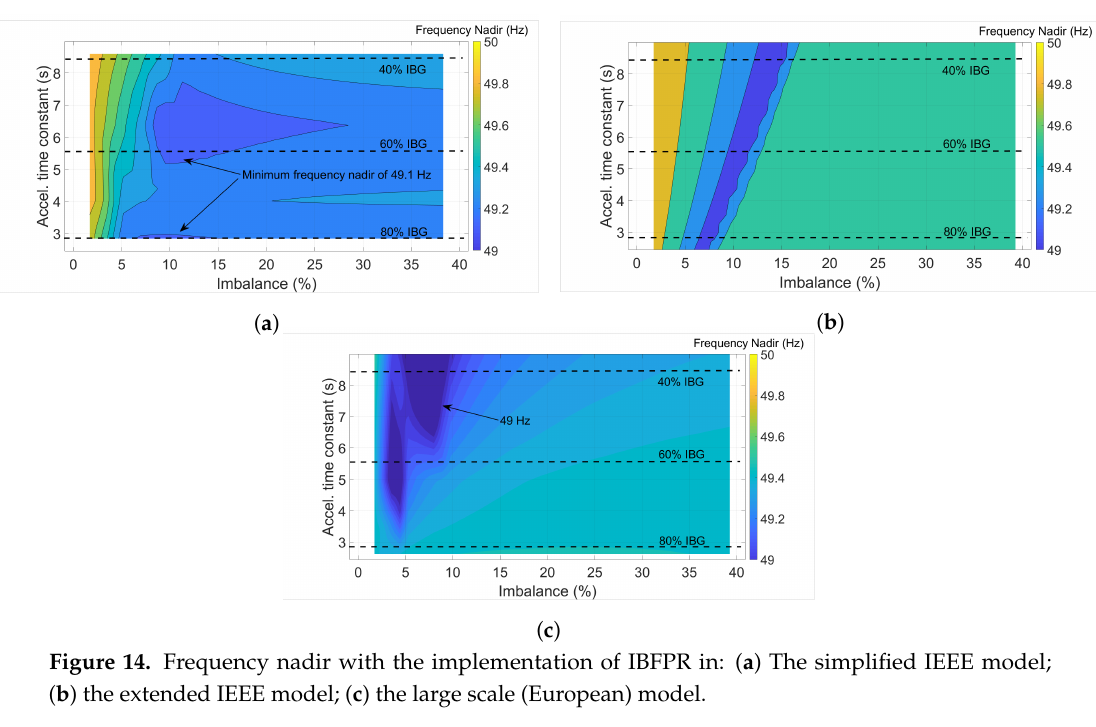
Figure 14. Frequency nadir with the implementation of IBFPR in: ( a ) The simplified IEEE model;